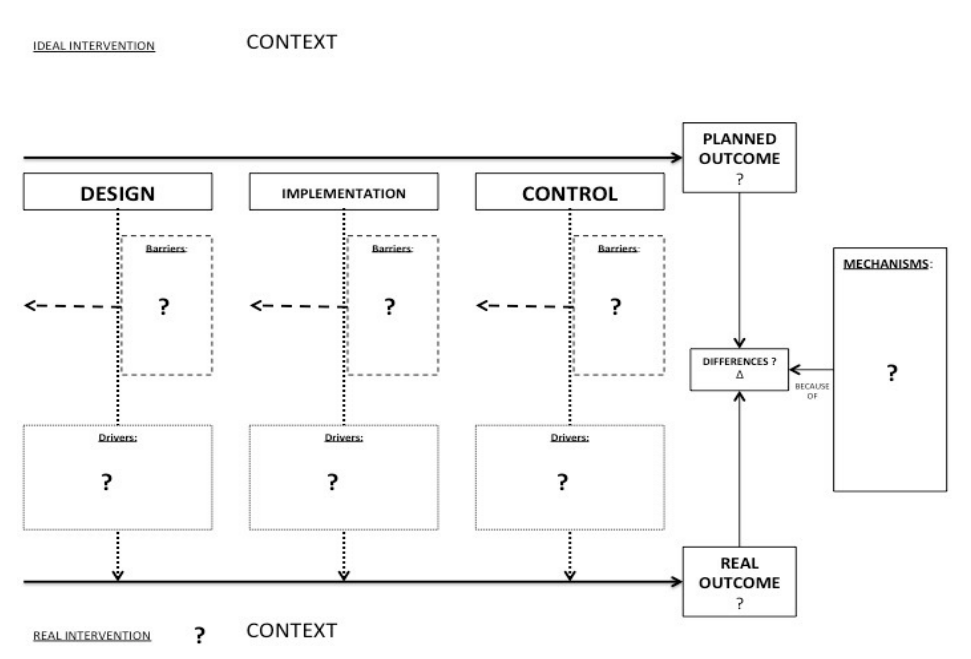
Figure 1. Conceptual research framework (“?” is the object of the investigation; “ ∆ ” is the difference between the planned outcome and the real outcome).